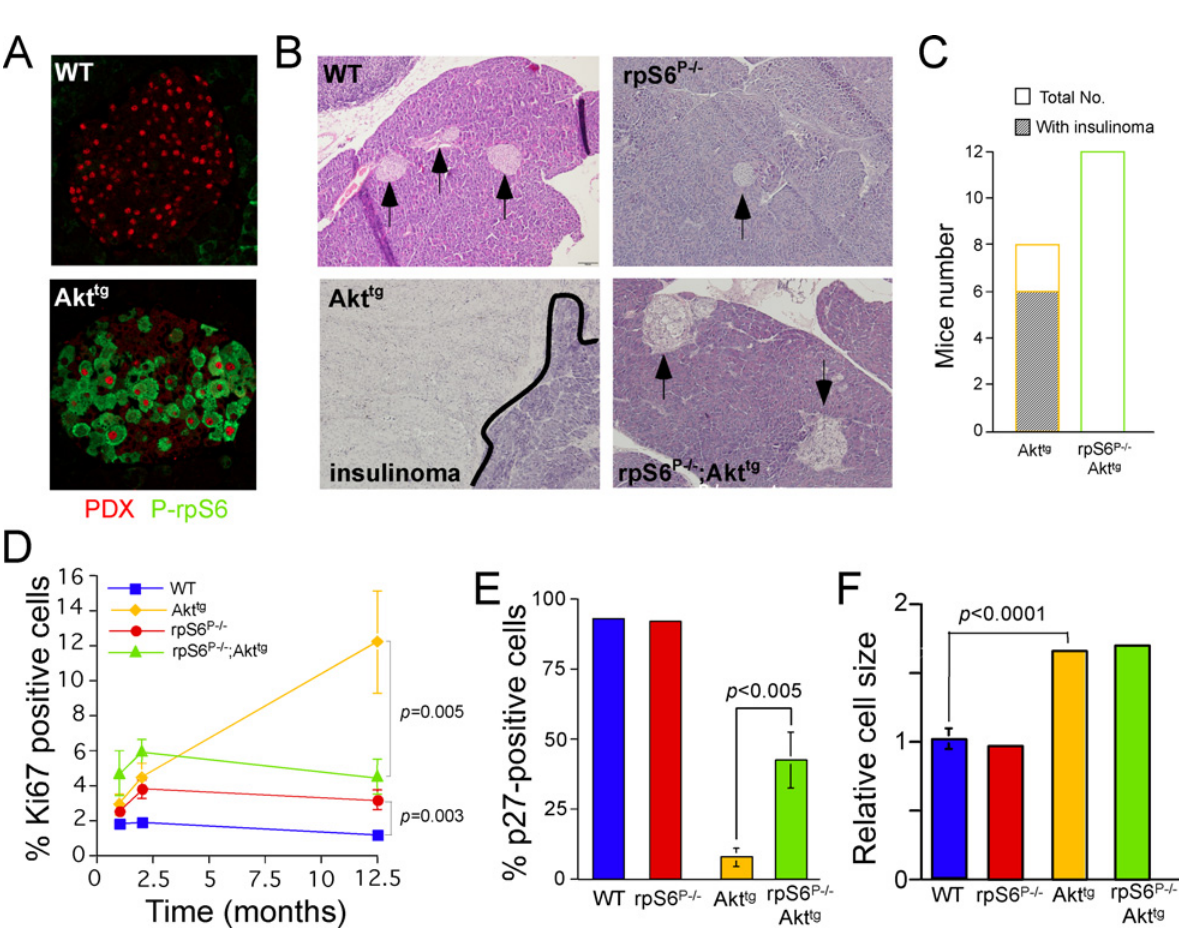
Fig 2. Rescue of rpS6 phosphorylation deficient mice from myr-Akt1-induced insulinoma is associated with decreased cell proliferation and increased p27 nuclear localization. (A) Pancreatic sections of islets from 12-month-old WT and Akt tg mice were stained for phosphorylated rpS6 and (green) and for β -cells nuclei by PDX1 antibodies (red). (B) Pancreatic sections from WT, rpS6 P-/- , Akt tg and rpS6 P-/- ;Akt tg 12-month-old mice were stained by haematoxylin-eosin. All images presented at the same magnification (see size bar [100 μ m] in WT). Arrows point to islets and the black line (lower left panel) marks the right margin of the insulinoma. (C) The number of mice with readily detectable insulinoma (dashed-line box) is presented within the total number of examined Akt tg and rpS6 P-/- ;Akt tg mice (open box). (D) Pancreatic sections from1, 2 and 10 to 15-mo-old mice of the indicated genotypes were stained as described in the legend to Fig 1D (see S3 Fig for representative islets from all 4 genotypes). The proliferation is presented as % Ki67 positive within insulin- positive cells. Values are presented as a mean ± SEM of counts derived from 20 to 50 islets identified in 3 to 4 mice of each genotype at each time point. (E) Pancreatic sections from 10 to 15-mo-old mice were stained for p27 and for insulin (see S4 Fig for representative islets from all 4 genotypes). Values are presented as a mean ± SEM of counts derived from 12 to 42 islets identified in 2 to 4 mice of each genotype. (F) The size of β -cells in 10 to 15-mo-old